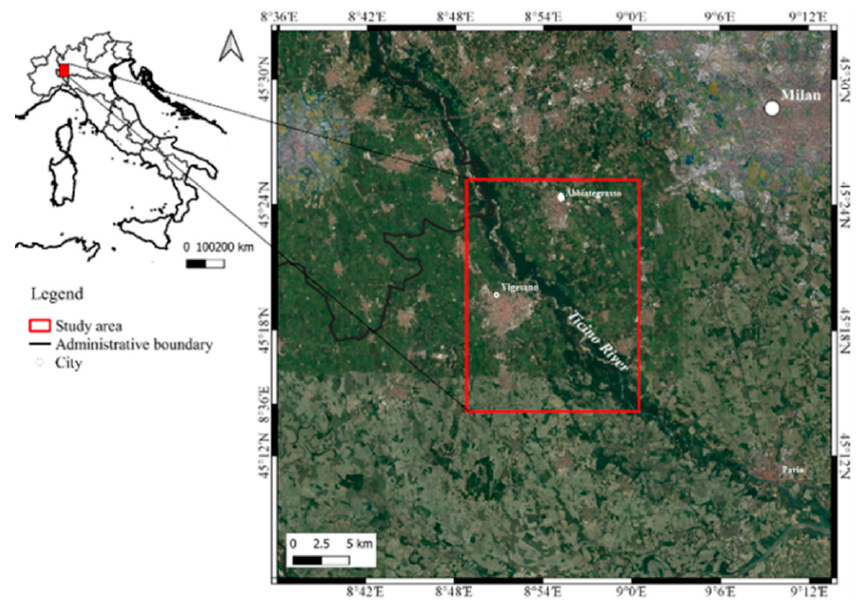
Figure 1. General overview of Italy and focus on the study area between Abbiategrasso and Vigevano in Pavia Province.